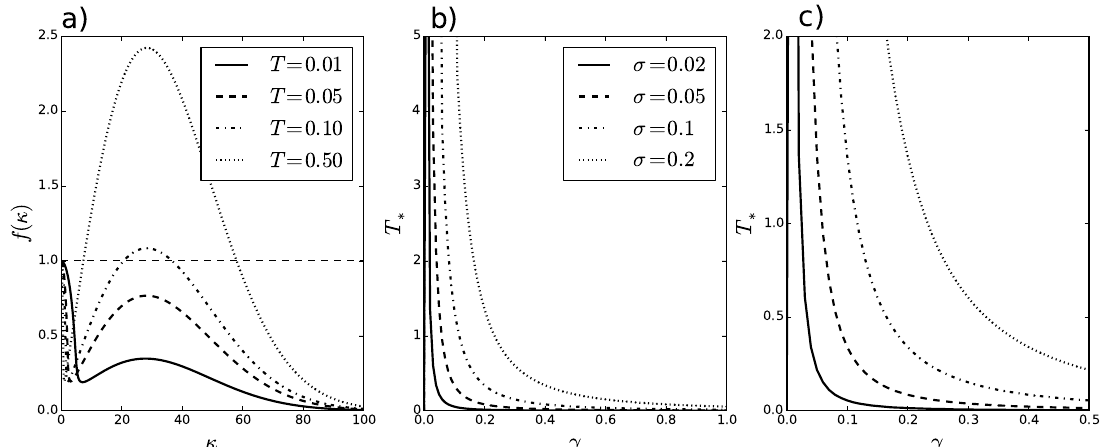
Figure 1. Critical value of T for pattern formation. In Panel ( a ), Equation (19) is plotted for γ = 0.2, σ = 0.05, and various values of T . Where f ( κ ) > 1, there is a Turing-Hopf instability. In Panels ( b , c ), the value, T ∗ , above which there is a Turing-Hopf instability for some κ and below which there is not, is plotted for various values of σ and γ